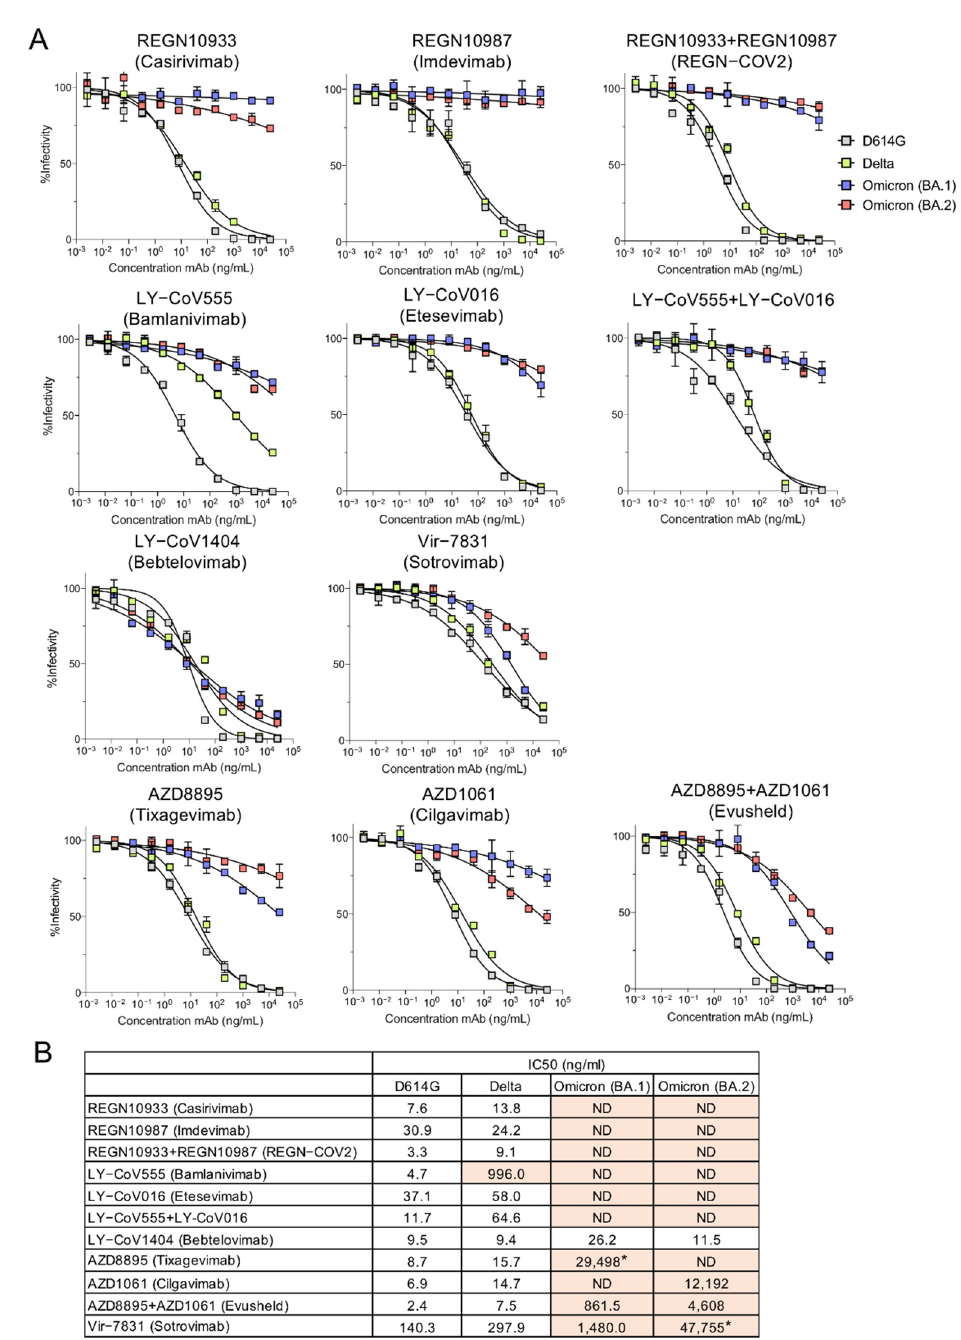
Figure 2. Neutralization of BA.2 by therapeutic monoclonal antibodies. ( A ) Lentiviral pseudotyped viruses were generated as previously described using codon-optimized 19 amino acid deleted spike proteins [24]. A fixed amount of virus, normalized for reverse transcriptase activity, was treated with 5-fold serially diluted monoclonal antibody, in duplicate, for 30 min and then used to infect ACE2.293T cells. Luciferase activity was measured after 24 h and the data are plotted as curves neutralized to luciferase activity in the absence of antibody. ( B ) The IC 50 was calculated from the neutralization curves by GraphPad Prism 8 software. Values that approached 50% neutralization were estimated, as indicated by an asterisk (*); those that did not approach 50% neutralization were not determined (ND). IC50s with >5-fold decrease in neutralizing titer are shown in orange.